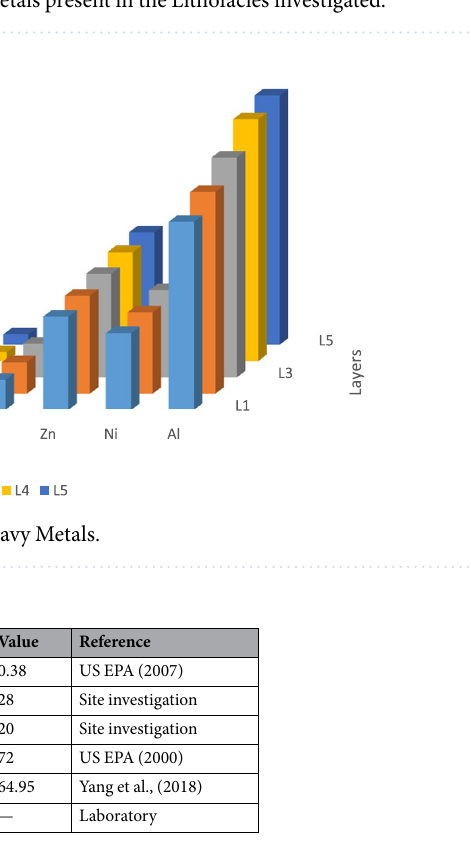
Figure 4. Mean concentration of the Heavy Metals present in the Lithofacies investigated.